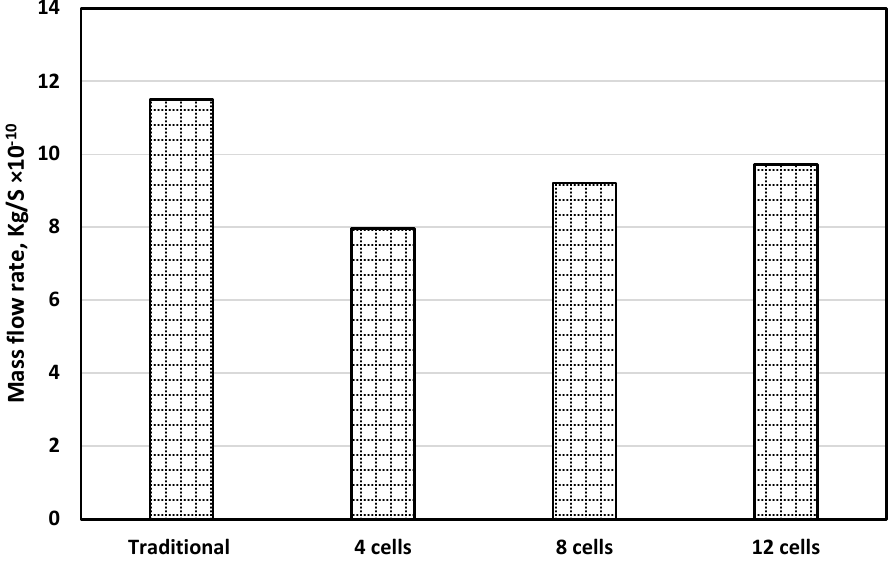
Figure 9. Hydrogen mass flow rate at the exit for different designs.